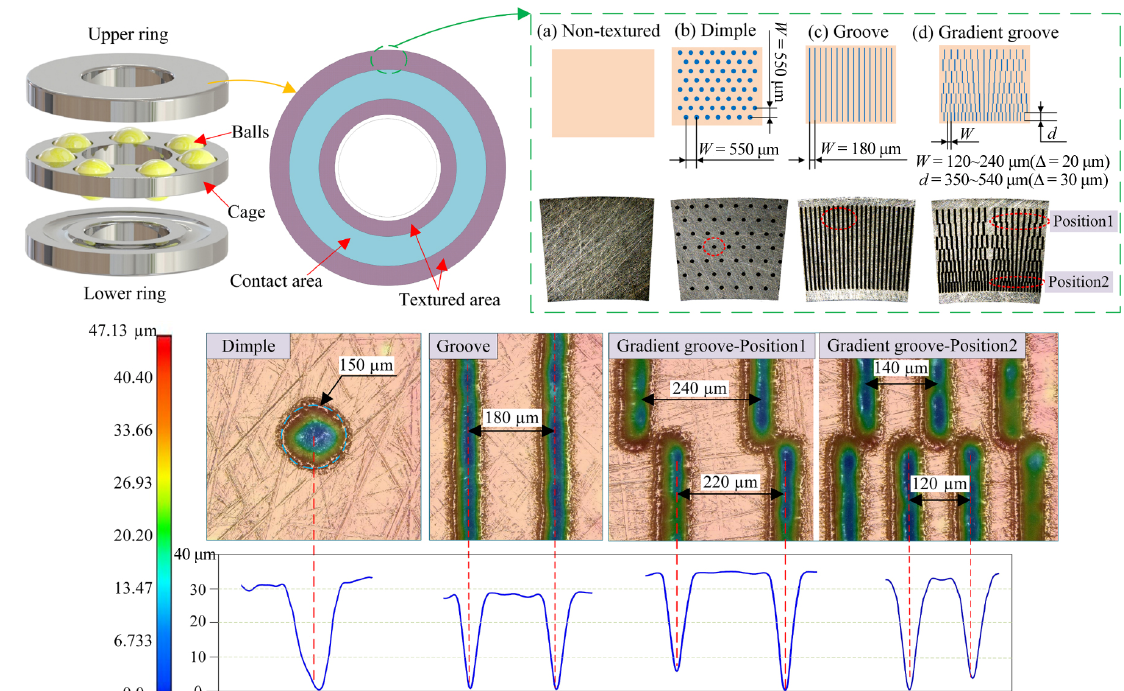
Fig. 2 Distribution and specific size of the texture on the guiding surface of the upper ring.